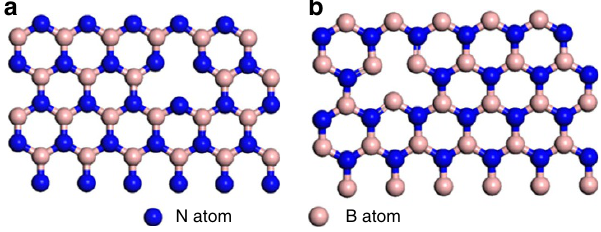
Figure 1 | Schematic illustration of h -BNNS with B and N vacancies. ( a ) h -BNNS with B vacancy and N-terminated edge. ( b ) h -BNNS with N vacancy and B-terminated